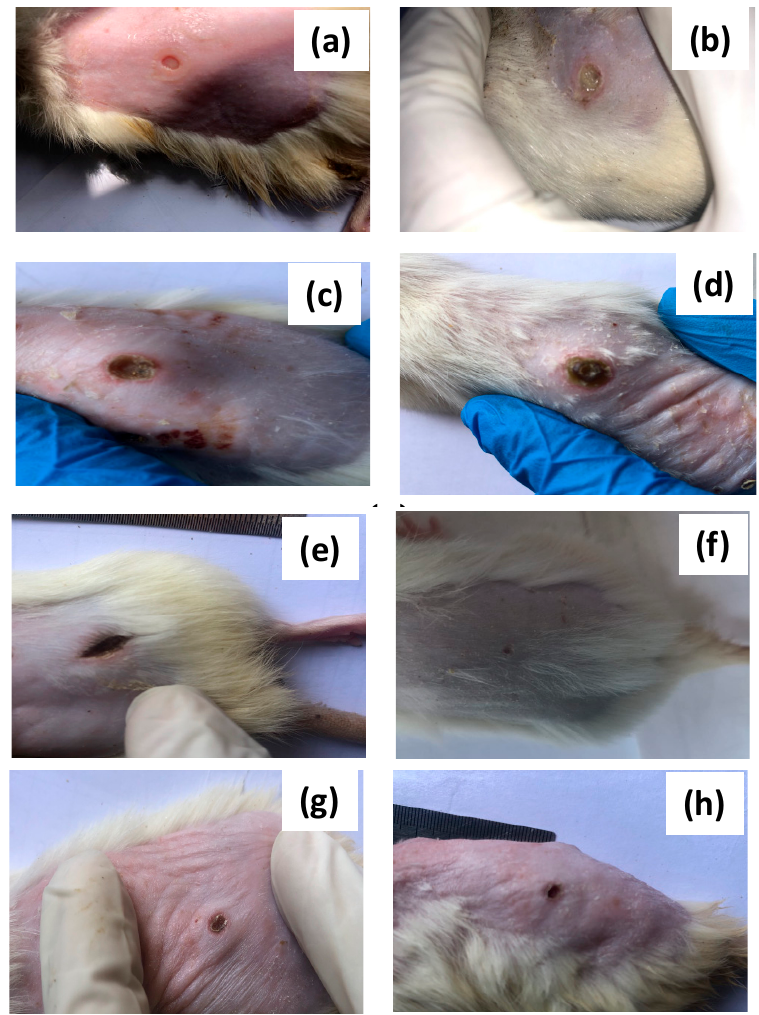
Figure 9. Wounded skin contraction in experimental rats after 7 days and the end of experiment (21 days). (1 and 2) revers to the treatment after 7 and 12 days, respectively. When ( a , b ) refers to the rats treated with cotton fabric (blank), ( c , d ) refers to the diabetic rats treated with ZnONPs-1@CF, ( e , f ) refers to the diabetic rats treated with ZnONPs-2@CF, and ( g , h ) refers to the diabetic rats treated with ZnONPs-3@CF. Table 2. Wound healing percent of diabetic rats treated with ZnONPs@CF.